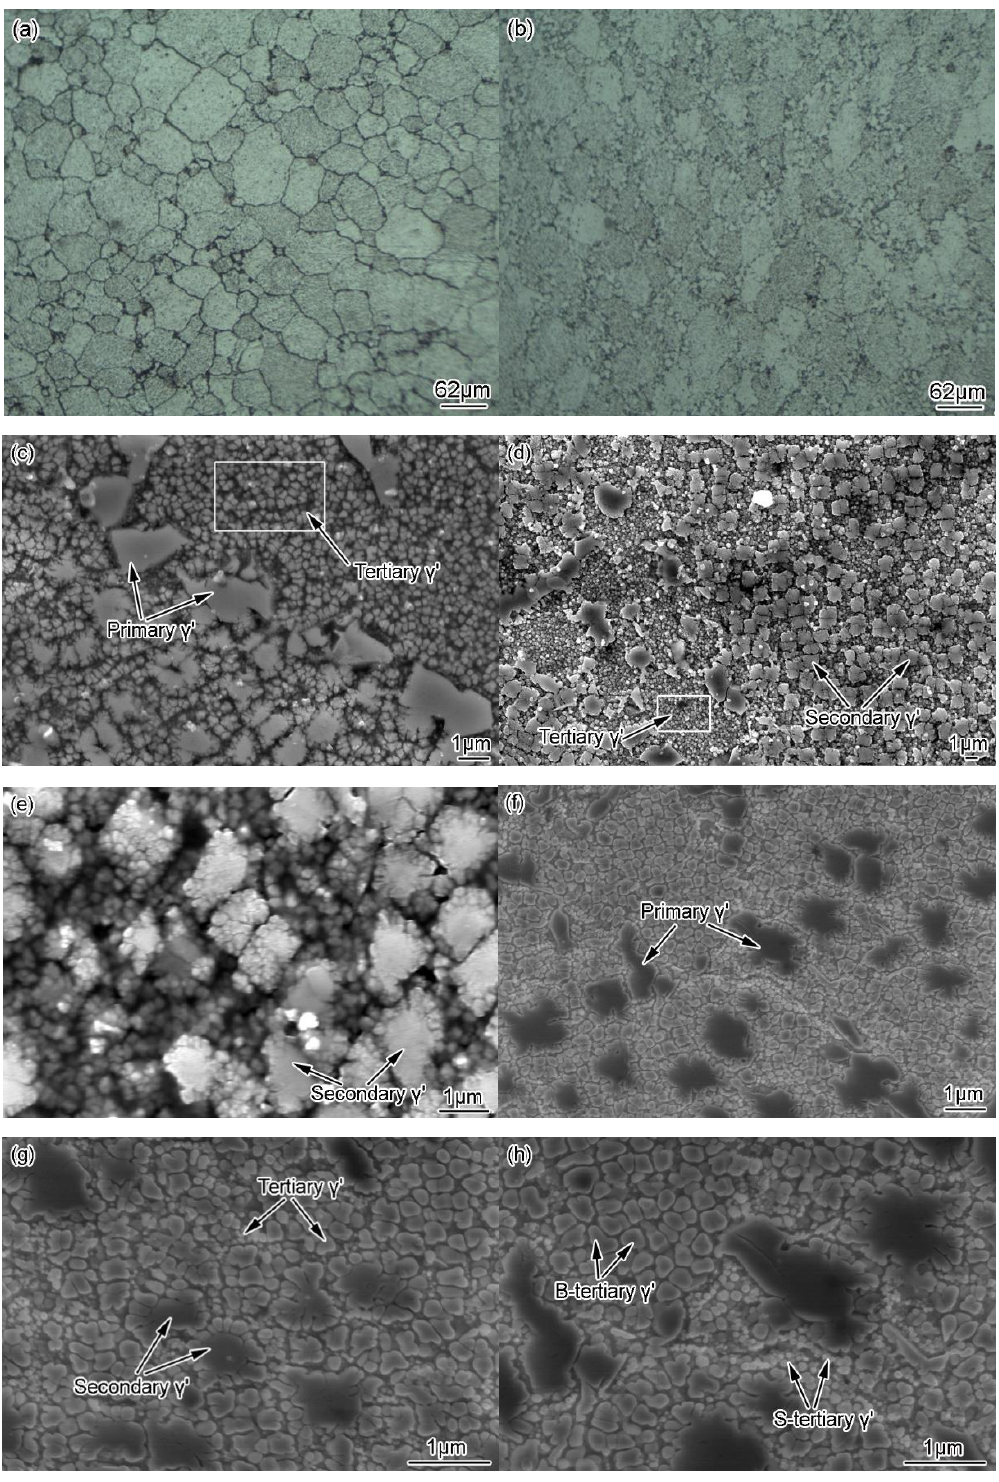
Figure 4. Microstructures of FGH100L alloy after creep at 705 ◦ C / 897 MPa: ( a ) OM images of HIPed alloy, ( b ) OM images of IFed alloy, ( c – e ) SEM images of HIPed alloy, and ( f – h ) SEM images of IFed